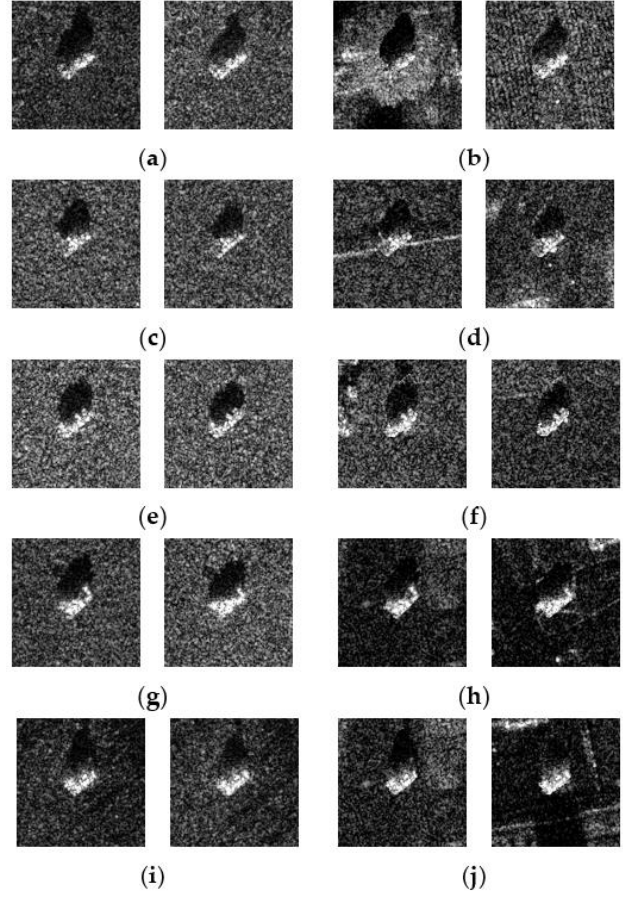
Figure 5. Original SAR images and corresponding clutter transfer results for five different types of targets measured at azimuth angle 48°-50° and elevation angles of 15° and 17°. It can be seen that the clutter backgrounds of the original SAR images for each type of target are highly correlated. ( a ) Original 2S1 (El =15° vs. 17°); ( b ) 2S1 with CT (El =15° vs. 17°); ( c ) Original BMP2 (El =15° vs. 17°); ( d ) BMP2 with CT (El =15° vs. 17°); ( e ) Original BTR70 (El =15° vs. 17°); ( f ) BTR70 with CT (El =15° vs. 17°); ( g ) Original T72 (El =15° vs. 17°); ( h ) T72 with CT (El =15° vs. 17°); ( i ) Original ZSU23 (El =15° vs. 17°); ( j ) ZSU23 with CT (El =15° vs. 17°).